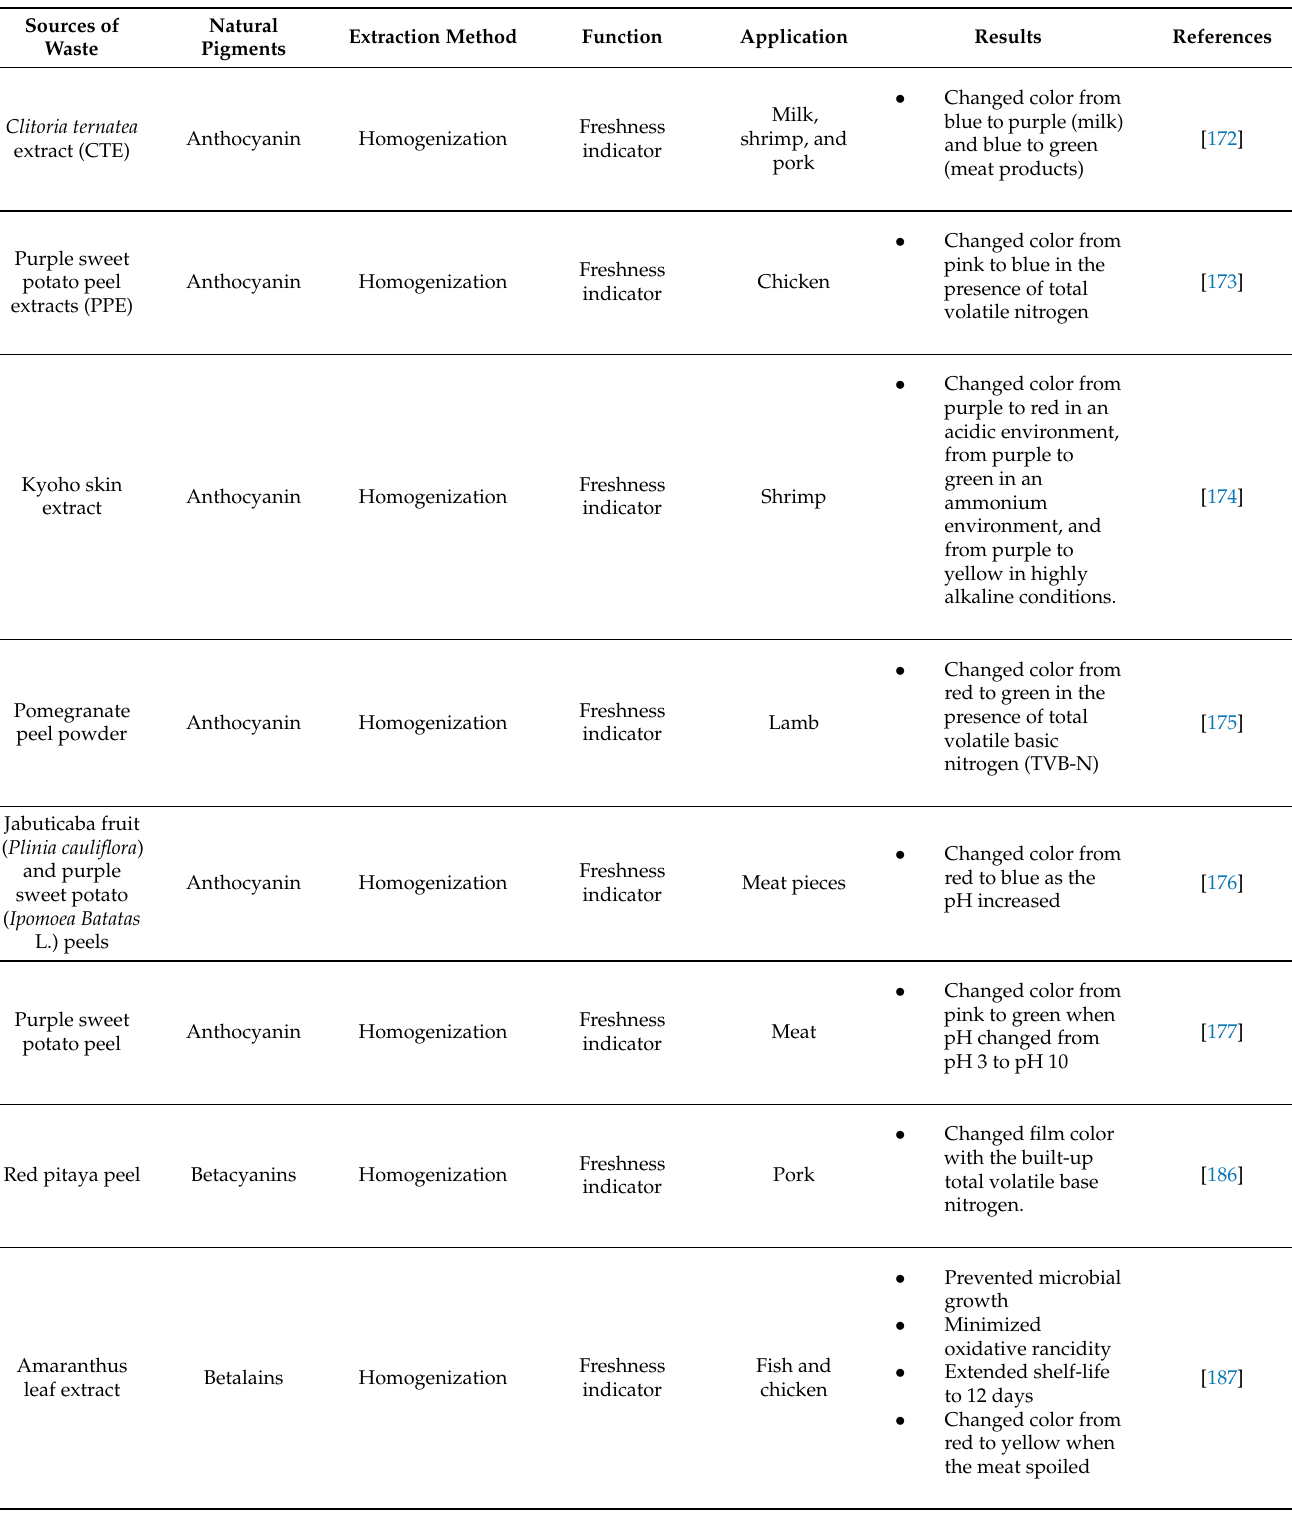
Table 6. Fruits and vegetables waste as natural colorant/indicators in food